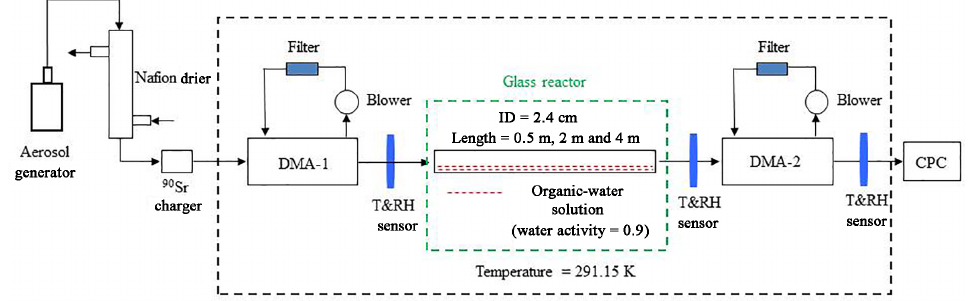
Figure 1. Schematic diagram of the experimental configuration. Table 1. Parameters of propylene glycol, butylene glycol, and tri-ethylene glycol. Organics Molecular Solubility Activity with Log 10 (C ∗ ) (cid:49)H (Vap) formula in water a w = 0.9 @25 ◦ C (KJmole − 1 ) (µgm − 3 ) Propylene Glycol C 3 H 8 O 2 Miscible Butylene Glycol C 4 H 10 O 2 Miscible